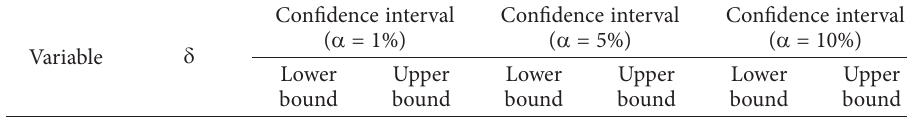
Table 7. Bootstrap truncated regression in the sensitivity analysis